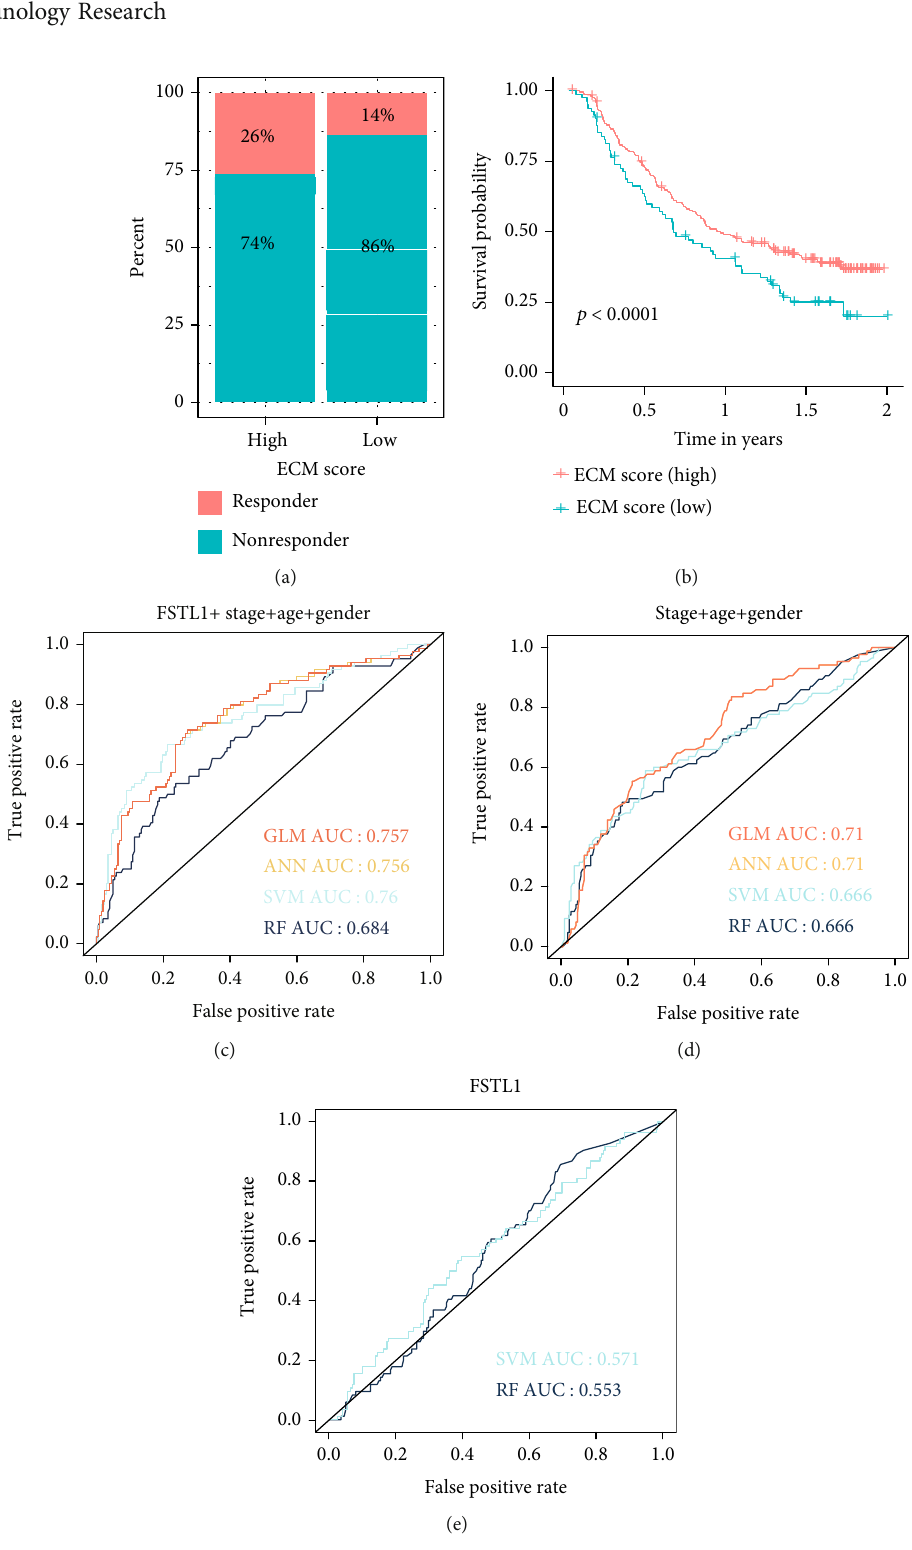
Figure 6: Evaluation of the association of ECM score with drug response to ICB and construction of machine learning models. (a) The correlation of the ECM score with the response rate to immunotherapy in the IMvigor210 dataset. (b) The correlation of the ECM score with the survival analysis in the IMvigor210 dataset. (c) Validation of machine learning models constructed by FSTL1, stage, age, and gender in the testing dataset based on AUC value. (d) Validation of machine learning models constructed by stage, age, and gender in the testing dataset based on AUC value. (e) Validation of machine learning models constructed by FSTL1 in the testing dataset based on AUC value. AUC: area under the receiver operating characteristic curve; RF: random